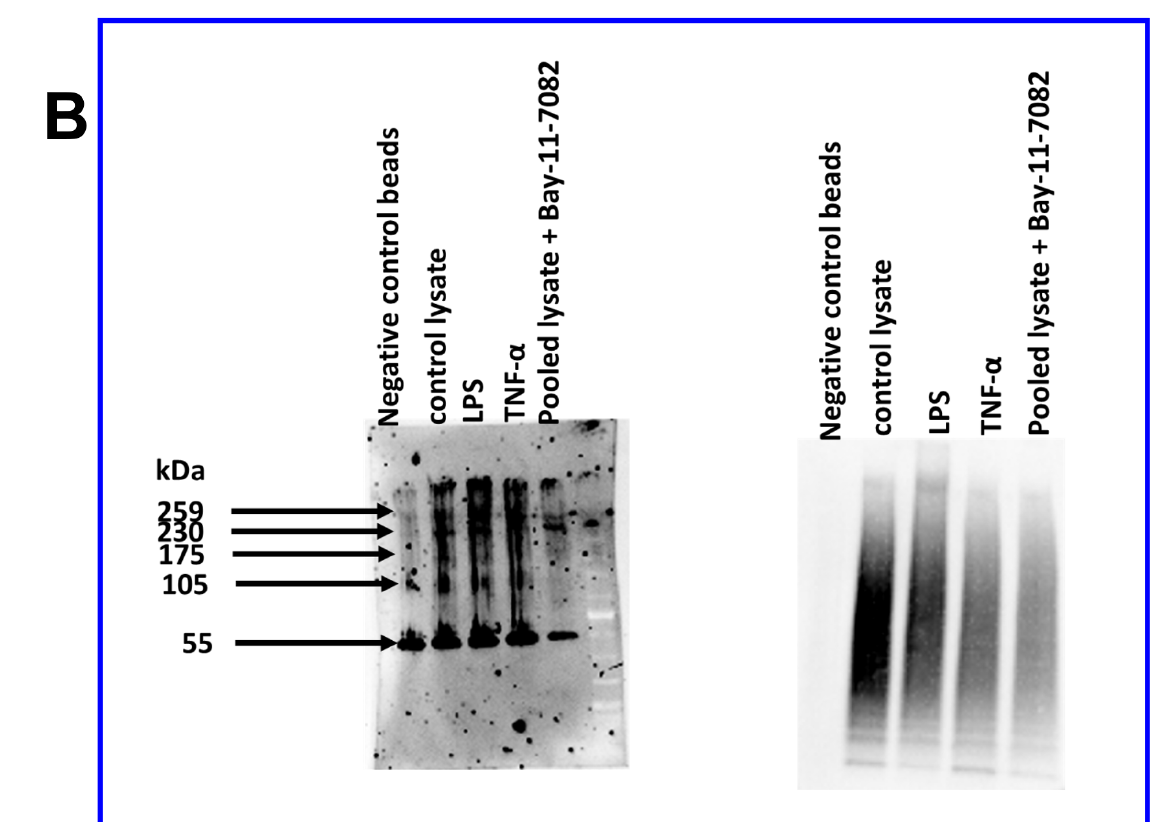
Figure 10. Immunoblots of JAM-B in lysates of THP-1 monocyte whole cells, nuclear and cytosolic sub- fractions of THP-1 cells with and without treatment with 10 µ M Bay-11-7082 inhibitor. ( A ) Immunoblot of nuclear (lane 1), cytoplasmic (lane 2) and whole cell lysates (lane 3) probed with anti-JAM-B antibodies. ( B ) Immunoblots of ubiquitin-enriched samples of whole cell lysates prepared by immunoprecipitation probed with anti-JAM-B antibodies ( left panel ) and anti-ubiquitin antibody ( right panel ). Negative control beads denote samples obtained following the immunoprecipitation procedure with negative control beads; control lysate was ubiquitin-captured samples from unstimulated/untreated cells, or cells treated with either 10 ng/mL LPS or 10 ng/mL TNF- α are ubiquitin-captured lysates from cells treated with inflammatory stimuli (LPS or TNF α ) and in samples pooled from Bay-11-7082 (10 µ M)-treated control and LPS- and TNF- α -treated